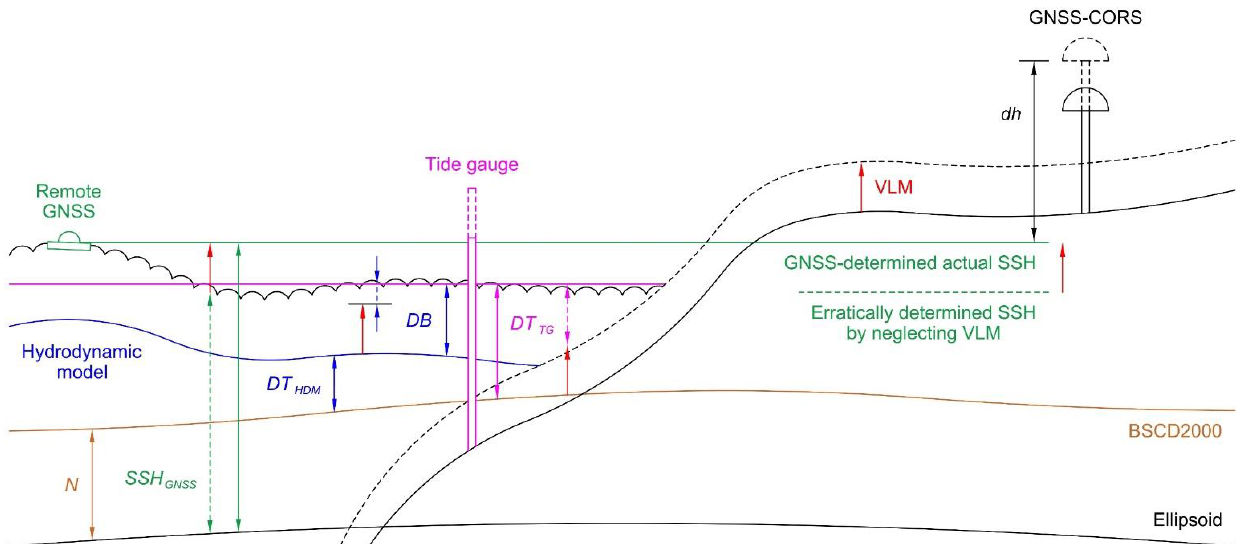
Figure 1. Interrelations between the used datasets. The solid lines denote geometry at a reference epoch, whereby the dashed lines show the vertical land motion (VLM) affected geometry at a GNSS observation epoch. Global sea level rise and geoid change trends are neglected for simplification (i.e., the sea’s surface is assumed to be unchanged). Notice that the depicted dynamic bias (DB) is negative, cf. Equation (3).